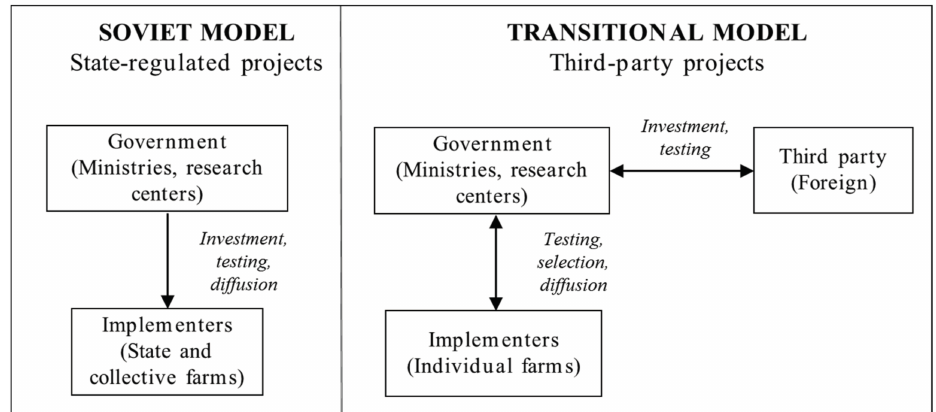
Figure 1. Models of innovation